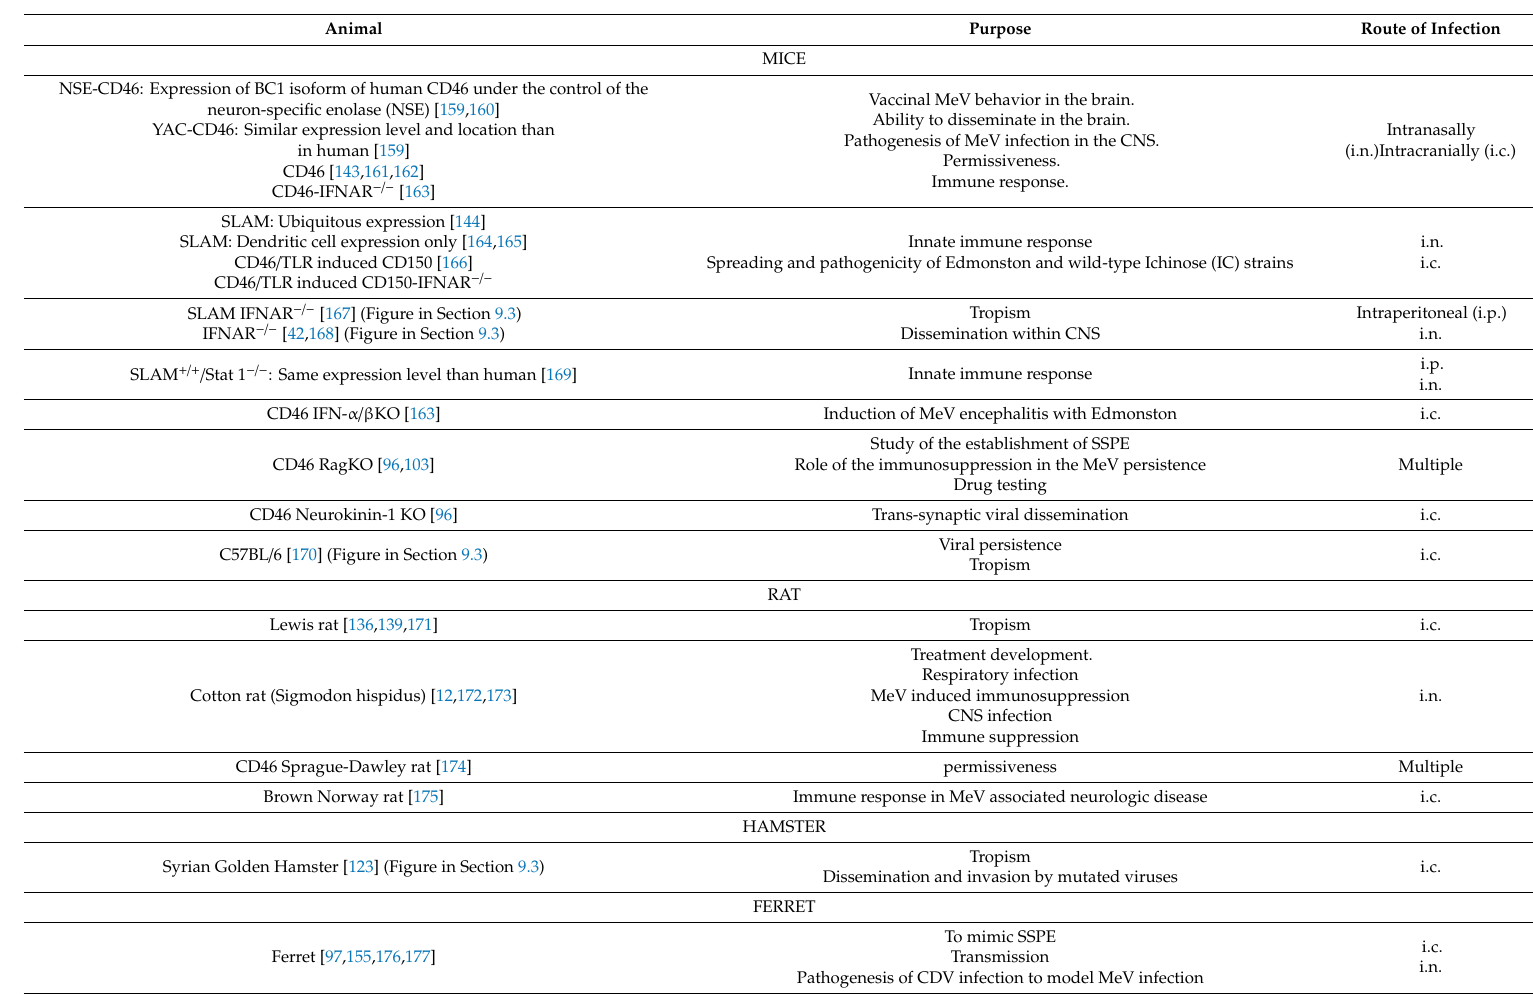
Table 1. Small animal models used to study MeV infection. IFNAR stands for interferon alpha / beta receptor, Rag for recombination activating gene, and TLR for Toll-like